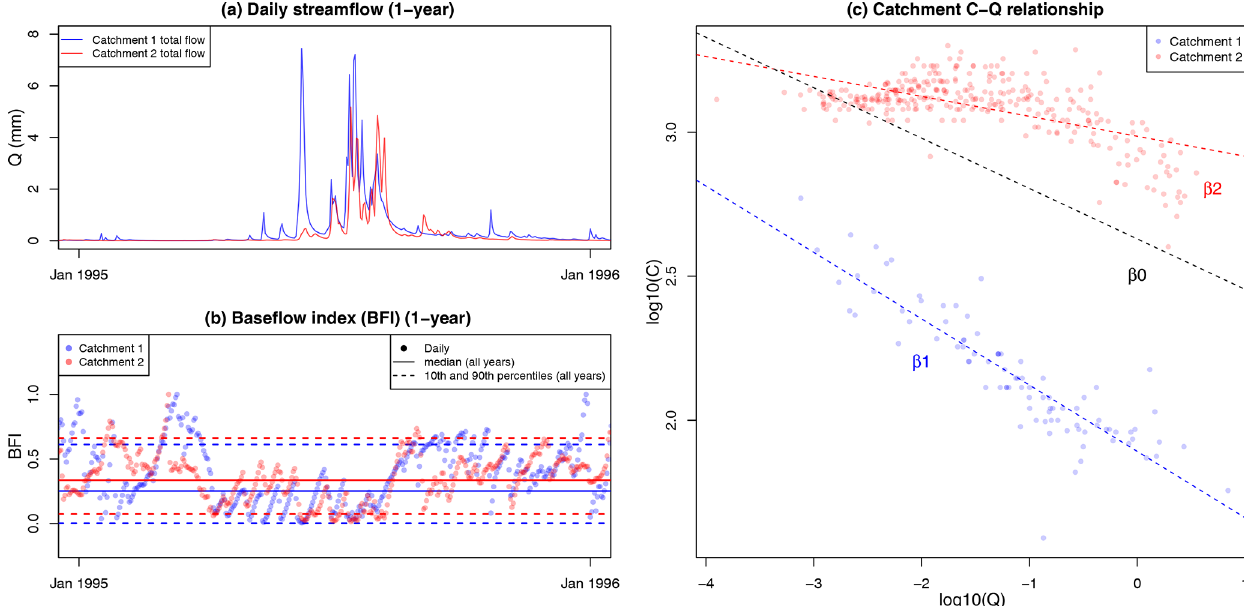
Figure 2. Illustration of conceptualization of the BFI-based C – Q models (Eq. 2) with the flow and EC data from two catchments. The catchment median BFI (BFI_m) is used as the main predictor of C – Q slope. (a) Daily flow time series. (b) Daily BFI time series and the corresponding median (BFI_m) and the 10th and 90th percentiles. (c) C – Q relationships for the two catchments, where the shift in C – Q slope ( β 1 , β 2 ) away from the grand mean β 0 is determined by BFI_m. Both time series for the daily flow (a) and BFI (b) are only shown for 1 year for